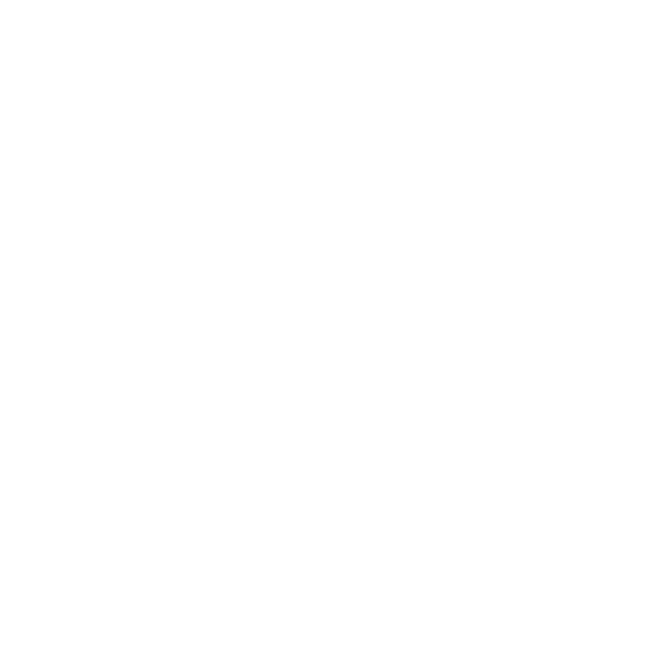
Flow chart of the bioinformatics analysis.